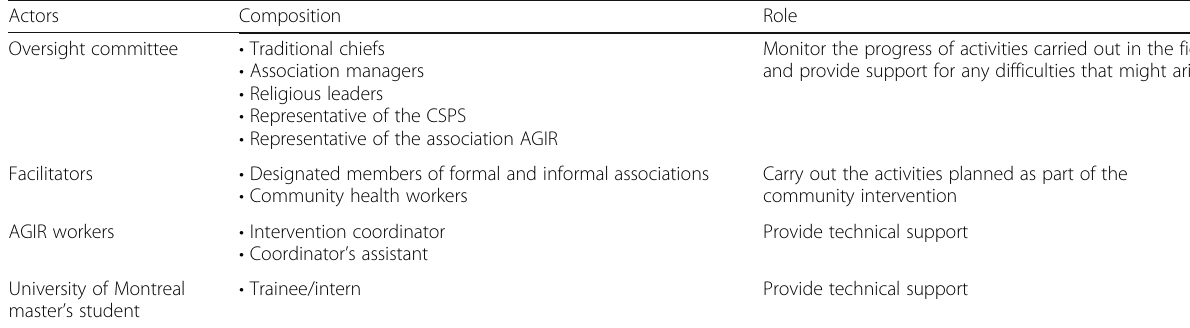
Table 1 The implementation actors and their role Actors